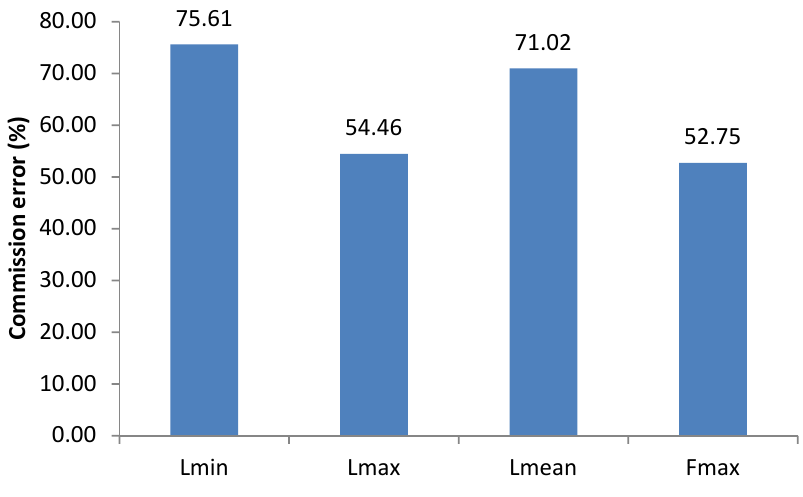
Figure 4. The percentage of commission errors for different surface models when using the local maximum finding as the tree detection